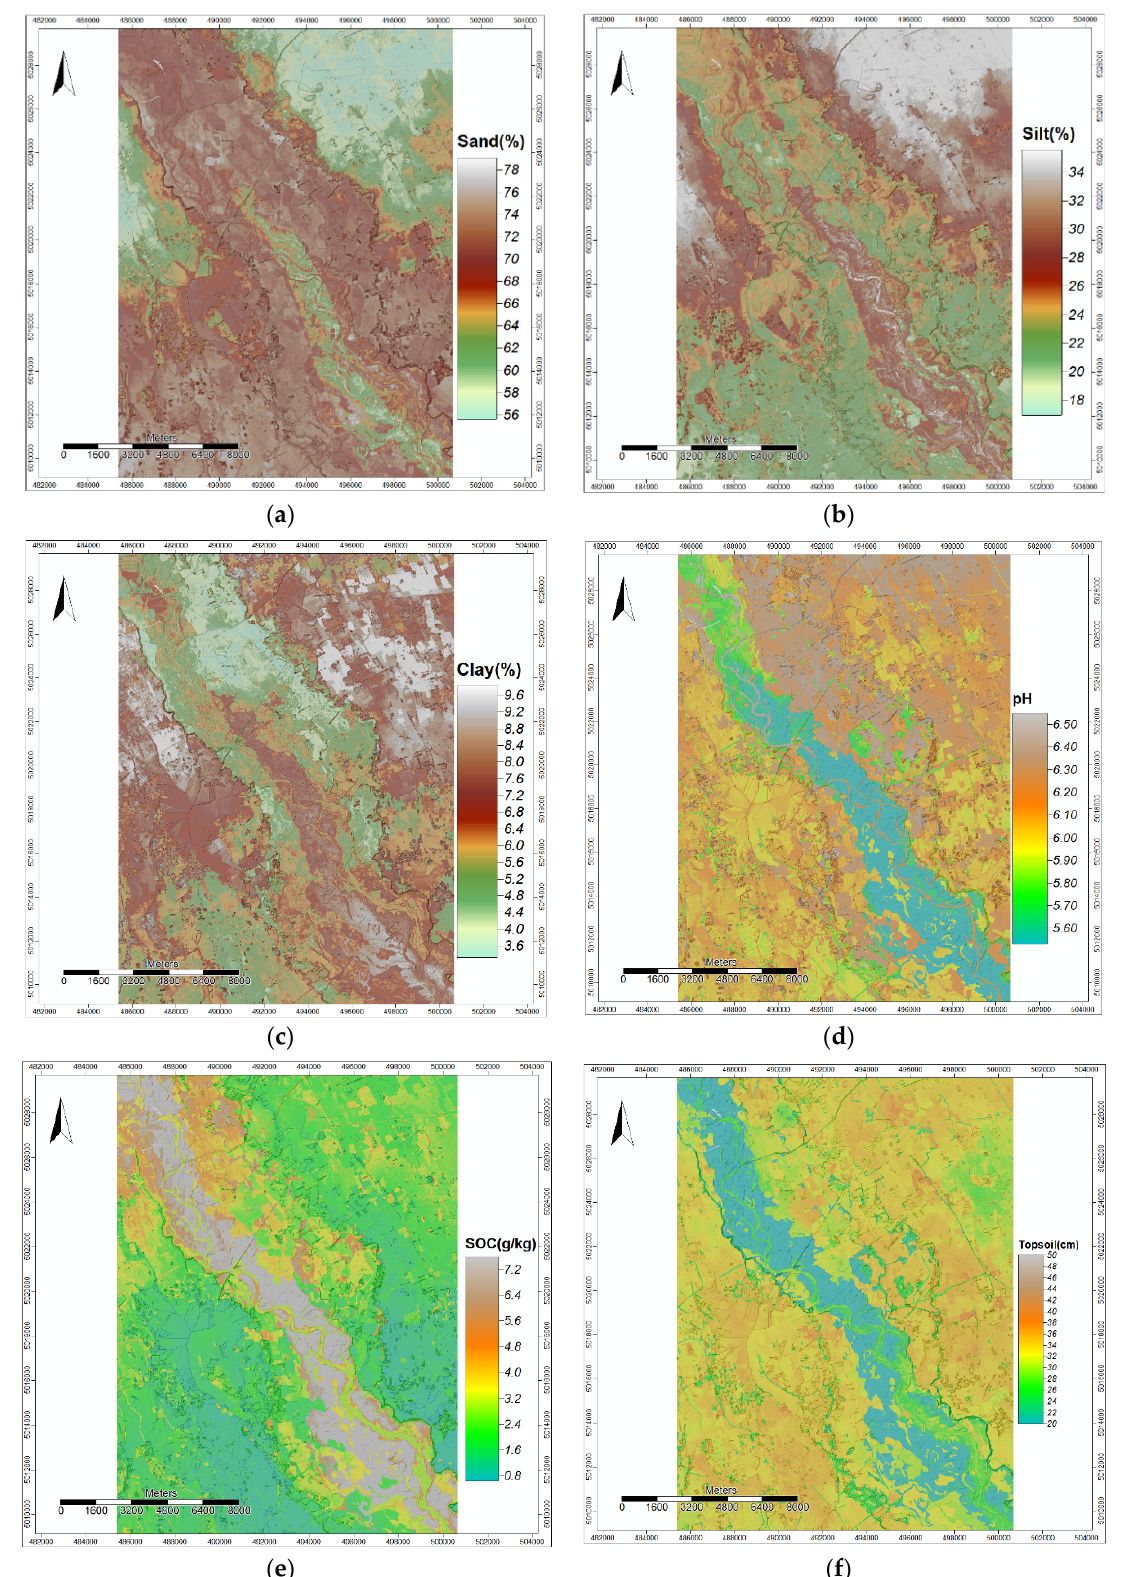
Figure 6. ( a – f ) Soil properties predicted with the best performing model for each response variable.